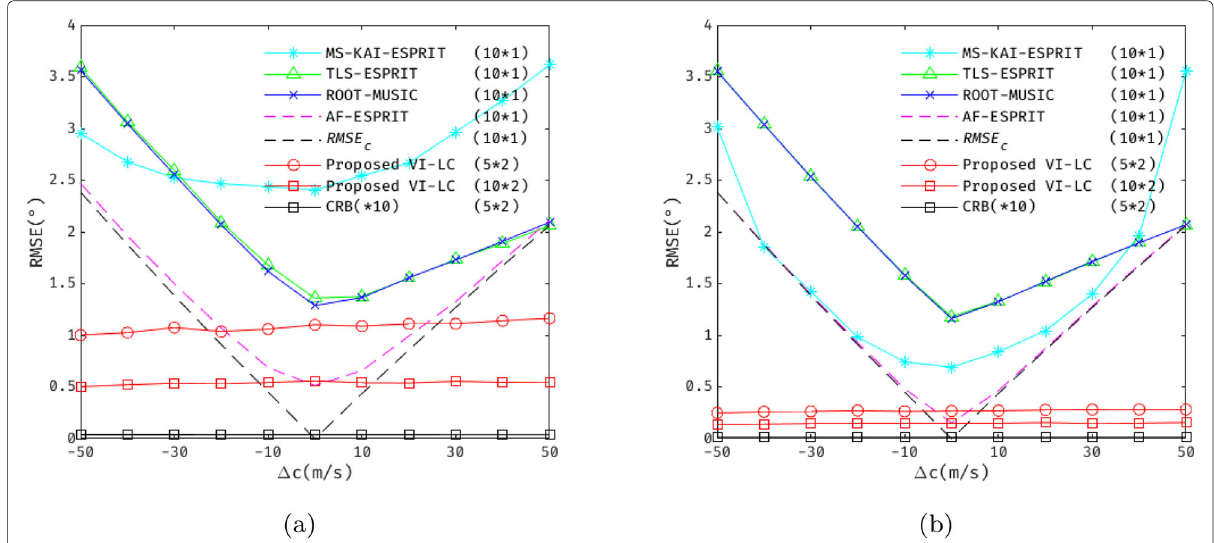
Fig. 7 RMSE versus (cid:8) c . a SNR = 0 dB and b SNR = 10